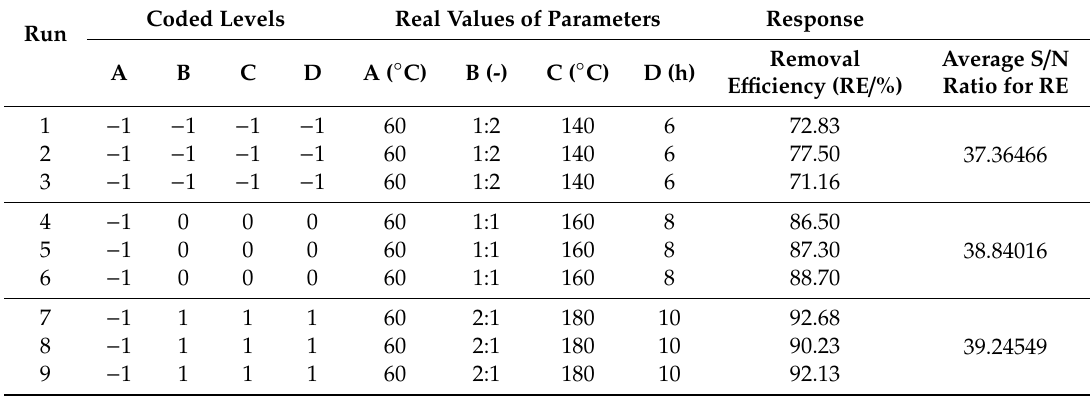
Table 3. Experimental designs and